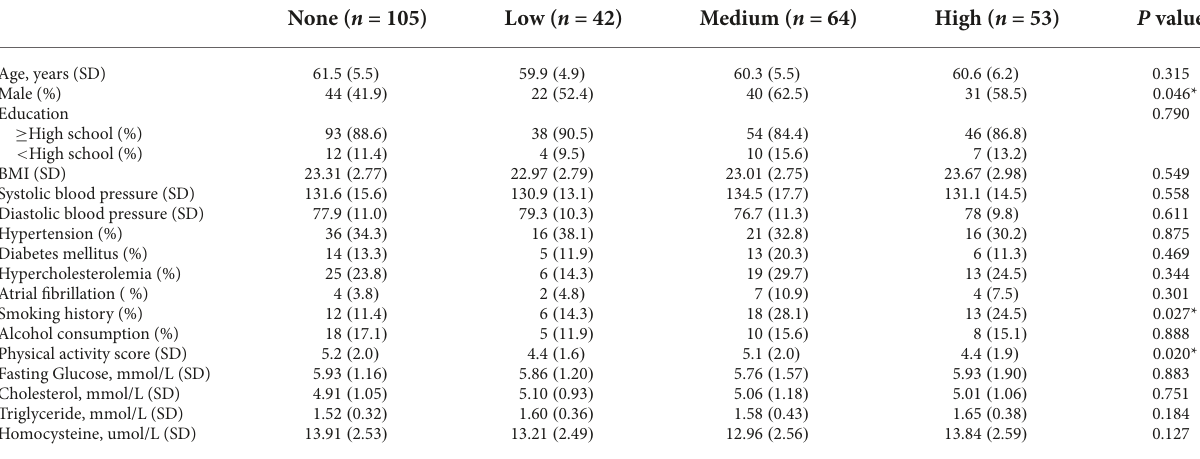
TABLE 3 Demographic and clinical characteristics of subgroup